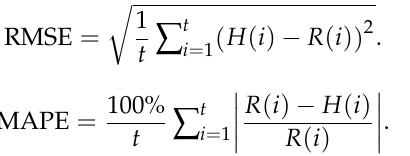
Figure 4. Fitting results of daily death rate.